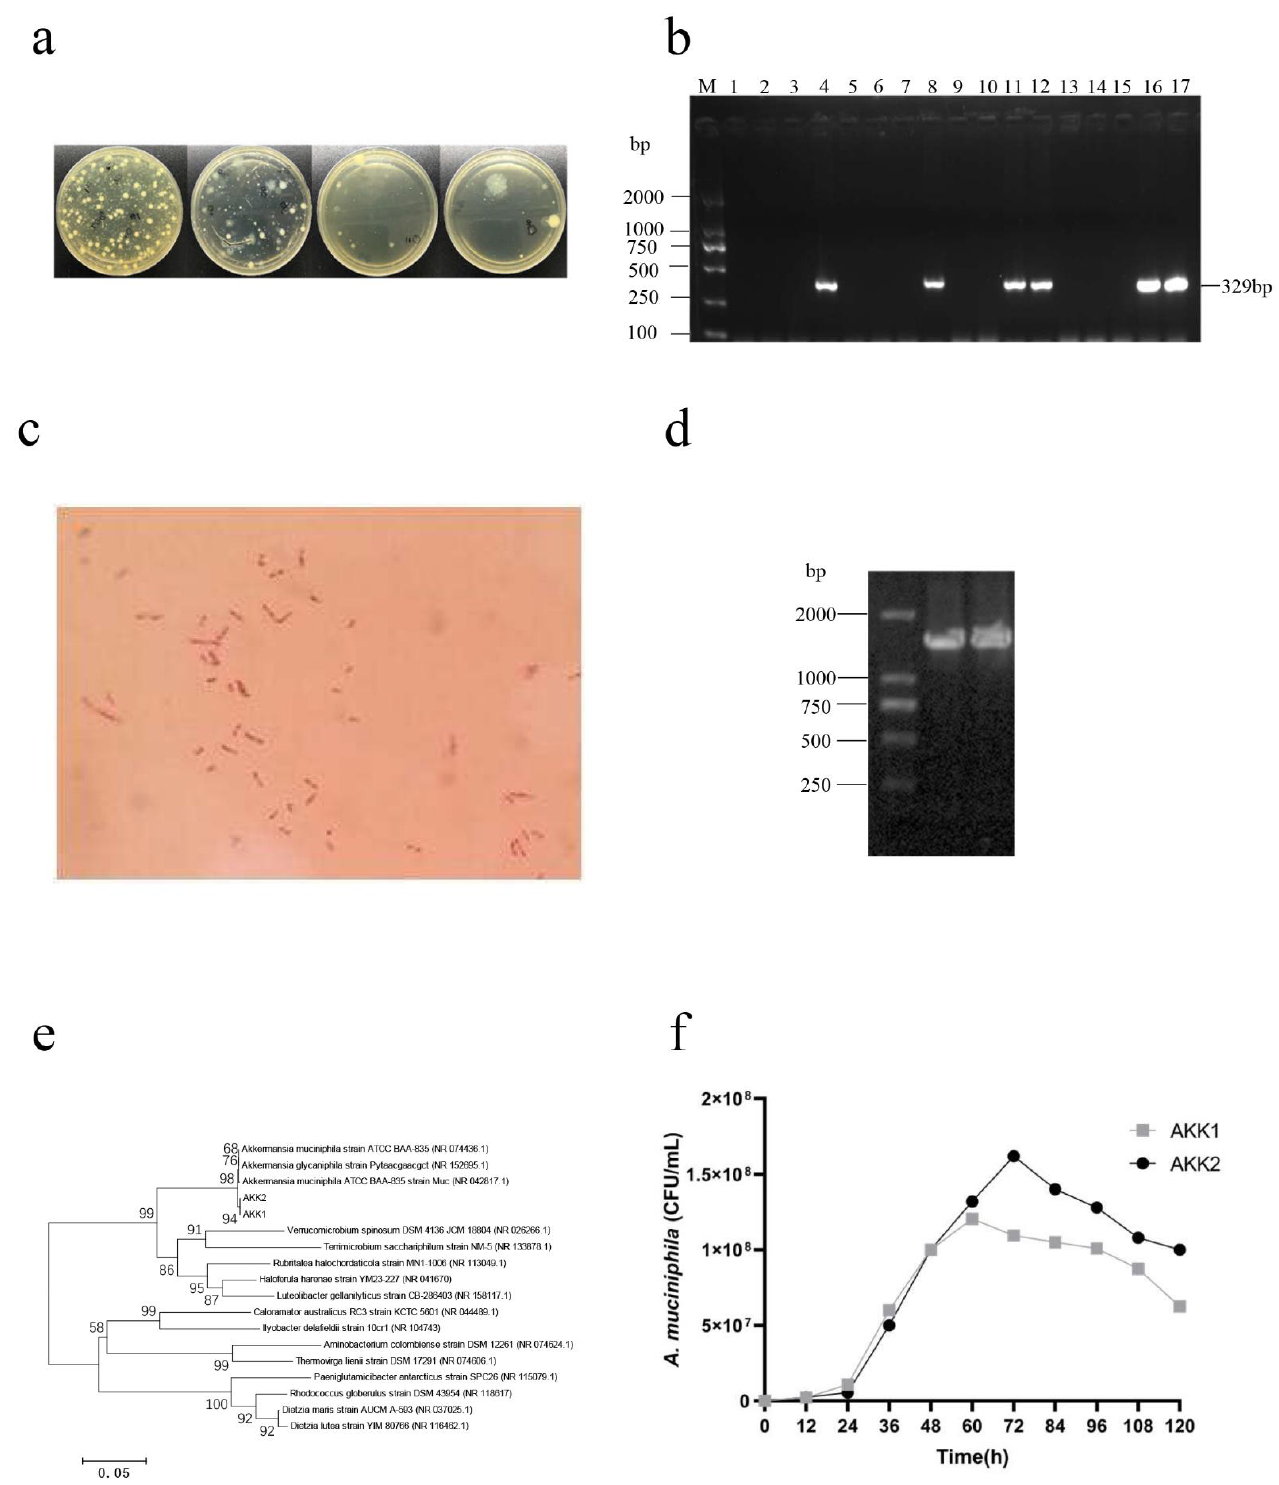
Figure 1. A. muciniphila strains were isolated from mouse feces. ( a ) The colony morphology on vancomycin solid medium. ( b ) The PCR gel electrophoresis of suspected A. muciniphila strains. M: DL2000 DNA Marker; 1–17: suspected isolates. ( c ) Gram staining of strains (1000 × ). ( d ) PCR products of isolates AKK1 and AKK2 on agarose gel. M, DL2000 DNA Marker; 1–2: Suspected isolates. ( e ) Phylogenetic analysis of strains by maximum likelihood method and the general time reversible model. ( f ) growth curve of A. muciniphila AKK1 and